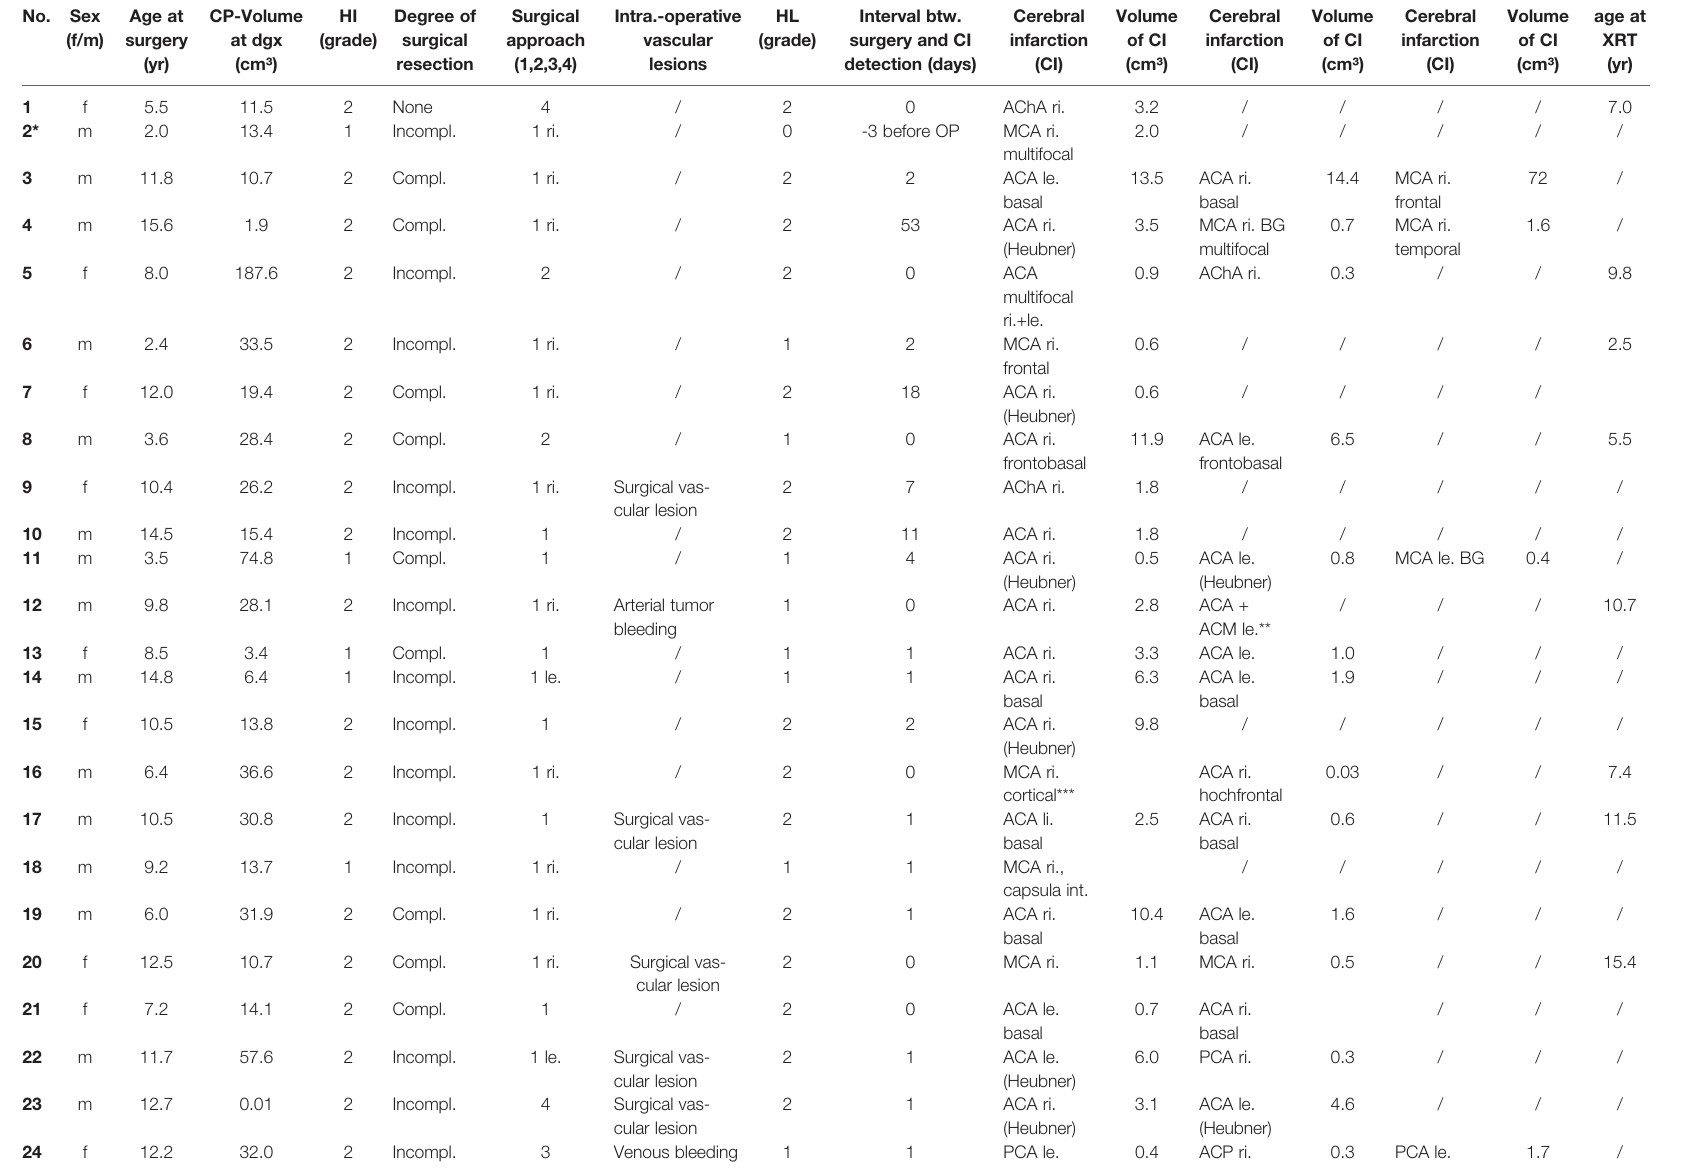
TABLE 2 | Characteristics of 26 patients with childhood-onset craniopharyngioma (CP) patients (recruited in KRANIOPHARYNGEOM 2007 between 2007 and 2019) with cerebral infarction (CI) con fi rmed by central neuroradiological review. No. Sex